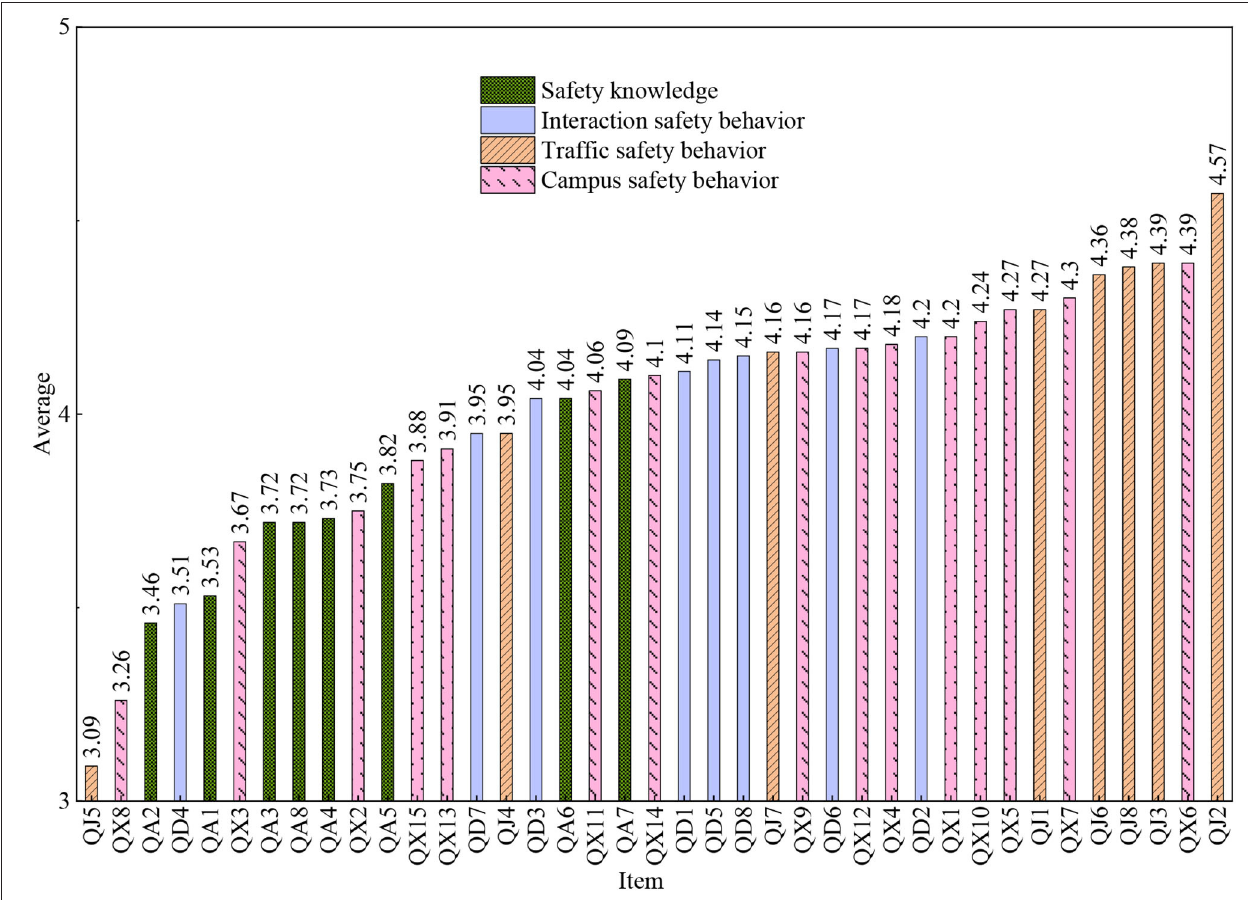
FIGURE 2 | Ranking of mean of each